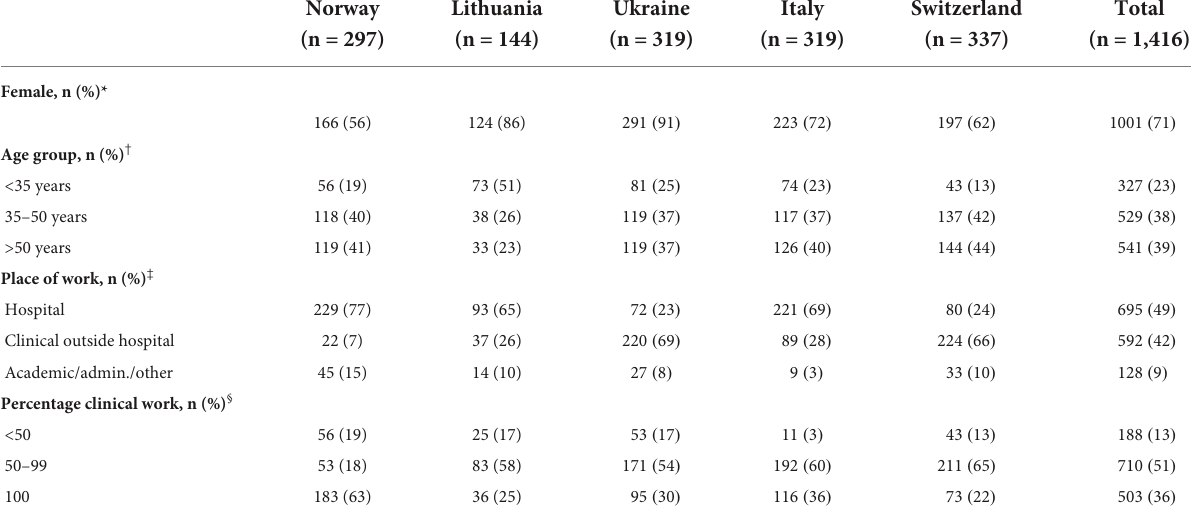
TABLE 1 Participants in survey of overtreatment/over-investigation in five European